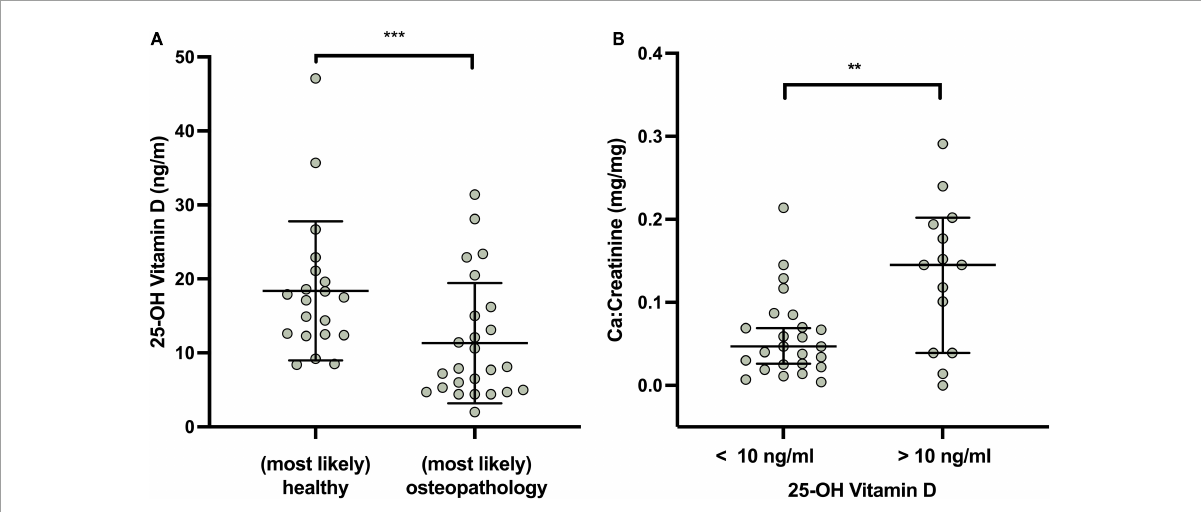
FIGURE3 Vitamin D (in ng/ml), osteopathologies and calcium metabolism in survivors. (A) Expert opinion and Vitamin D levels. (B) Urinary Ca/Creatinine in patients with severe vitamin D deficiency and normal vitamin D values. Lines indicate mean and standard deviation. Statistically significant differences between the groups, determined by Mann–Whitney test, are indicated with asterisks (*** P < 0.001; ** P < 0.01).